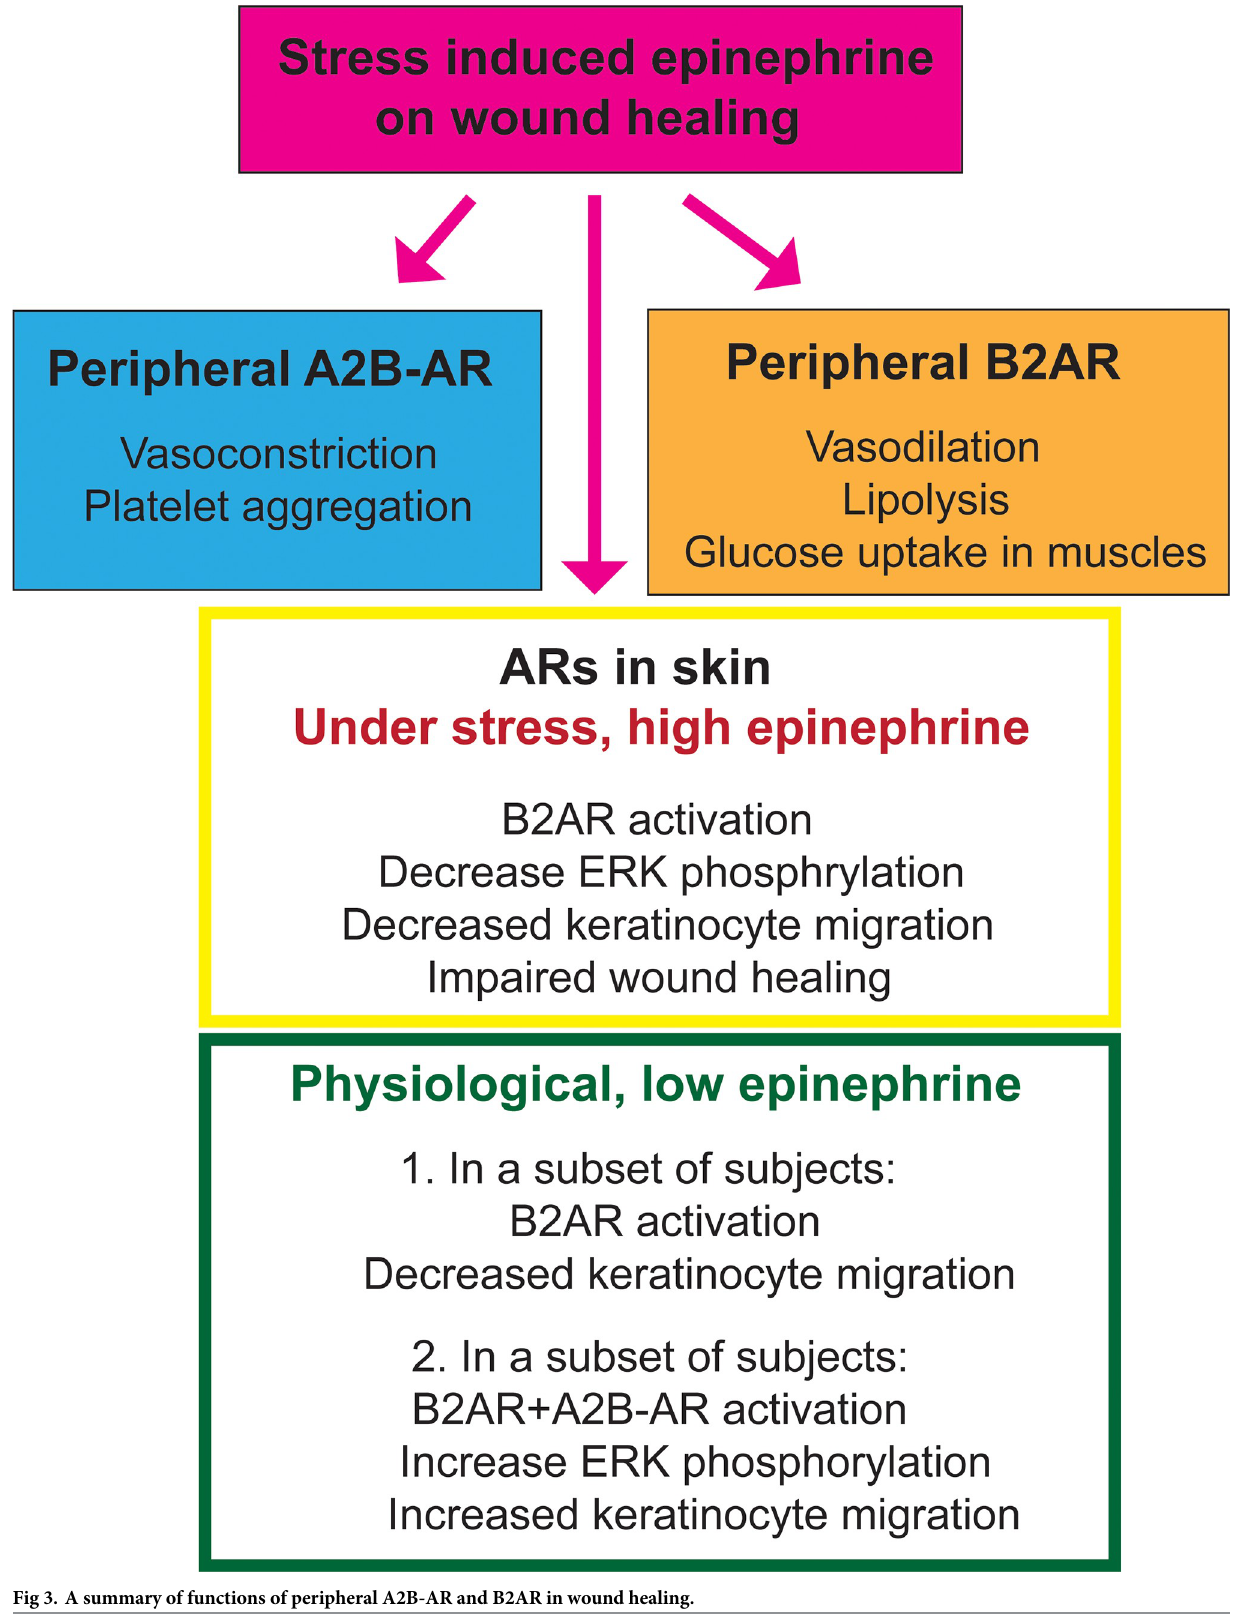
Fig 3. A summary of functions of peripheral A2B-AR and B2AR in wound healing. https://doi.org/10.1371/journal.pone.0253139.g003 PLOS ONE | https://doi.org/10.1371/journal.pone.0253139 July 2,